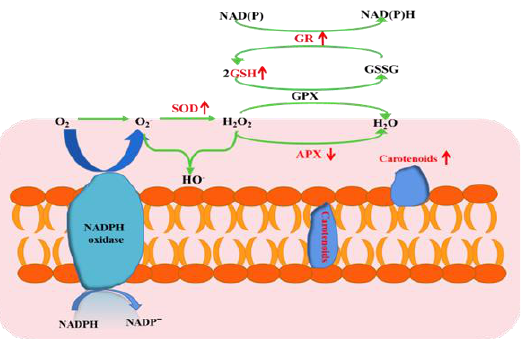
Figure 4. Biochemical reveals Planococcus sp. O5 copper tolerance mechanisms. The down and up arrow means down-regulation and up-regulation, respectively.